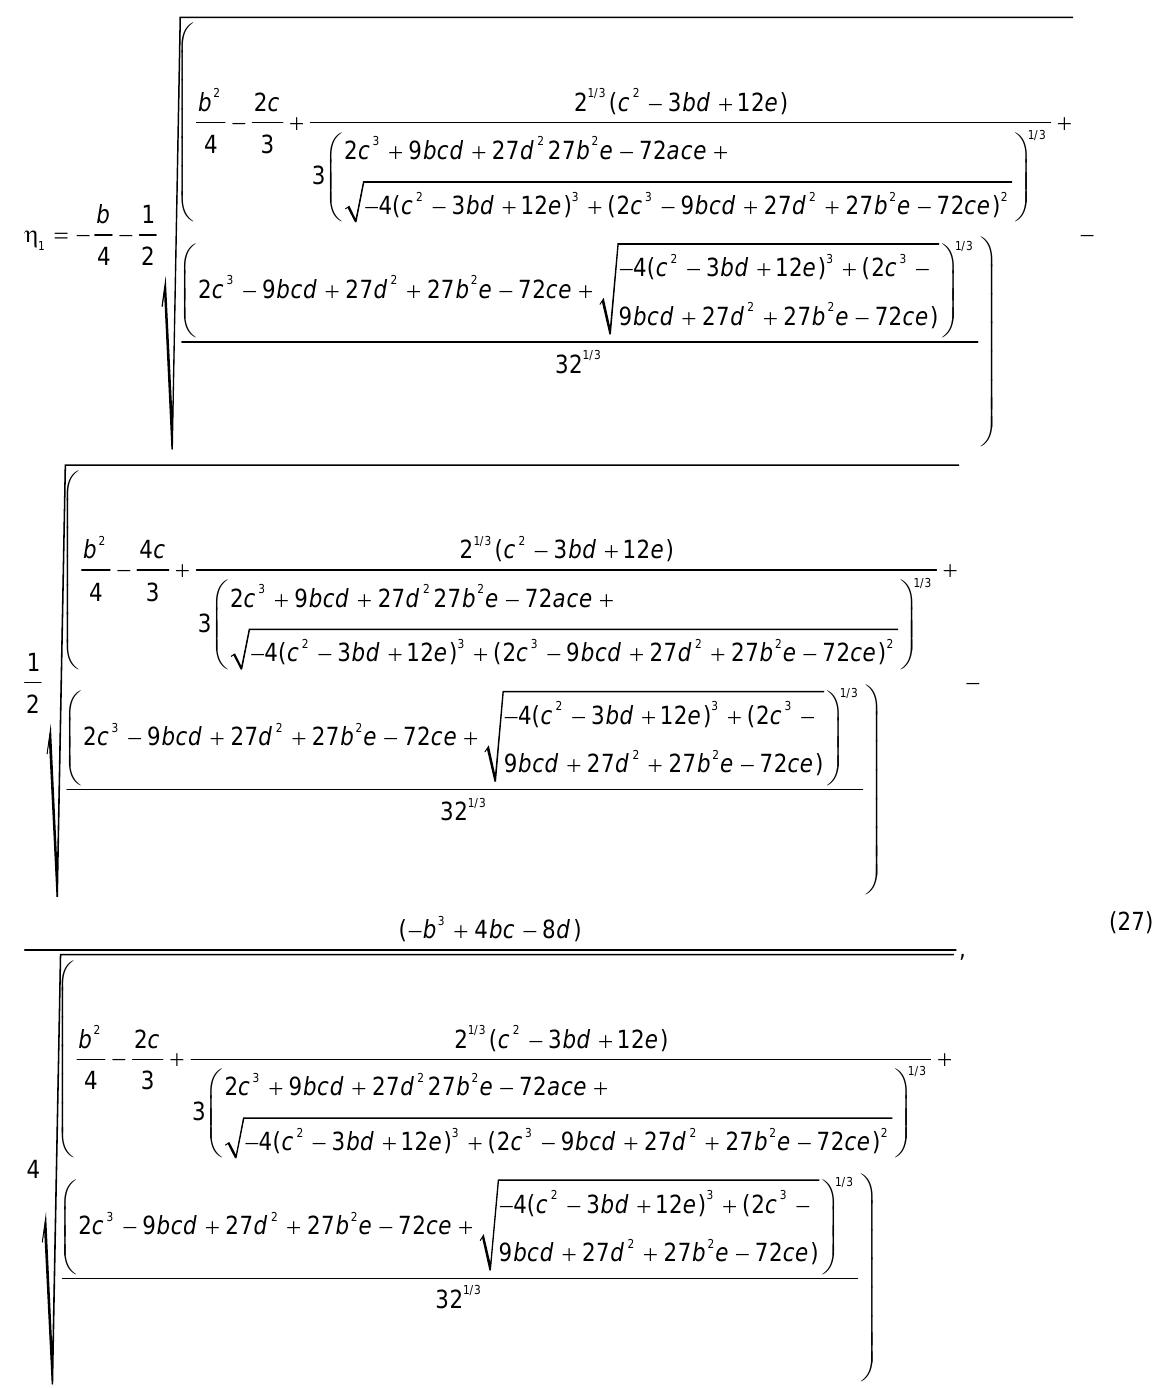
Table 1. Table values for materials, optical constants (  ,  ), intensity I